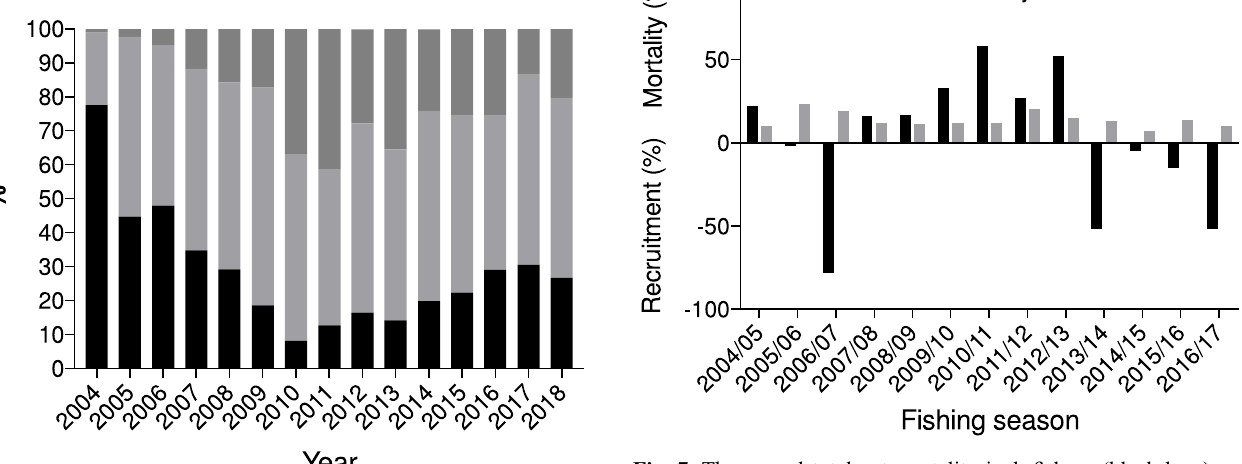
Fig. 7. The annual total net mortality incl. fi shery (black bars) and fi shery related mortality (grey bars) of fl at oysters ( Ostrea edulis ) within each fi shing season from 2004 to 2017. Negative values of total net mortality indicate that recruitments were larger than total net mortality.